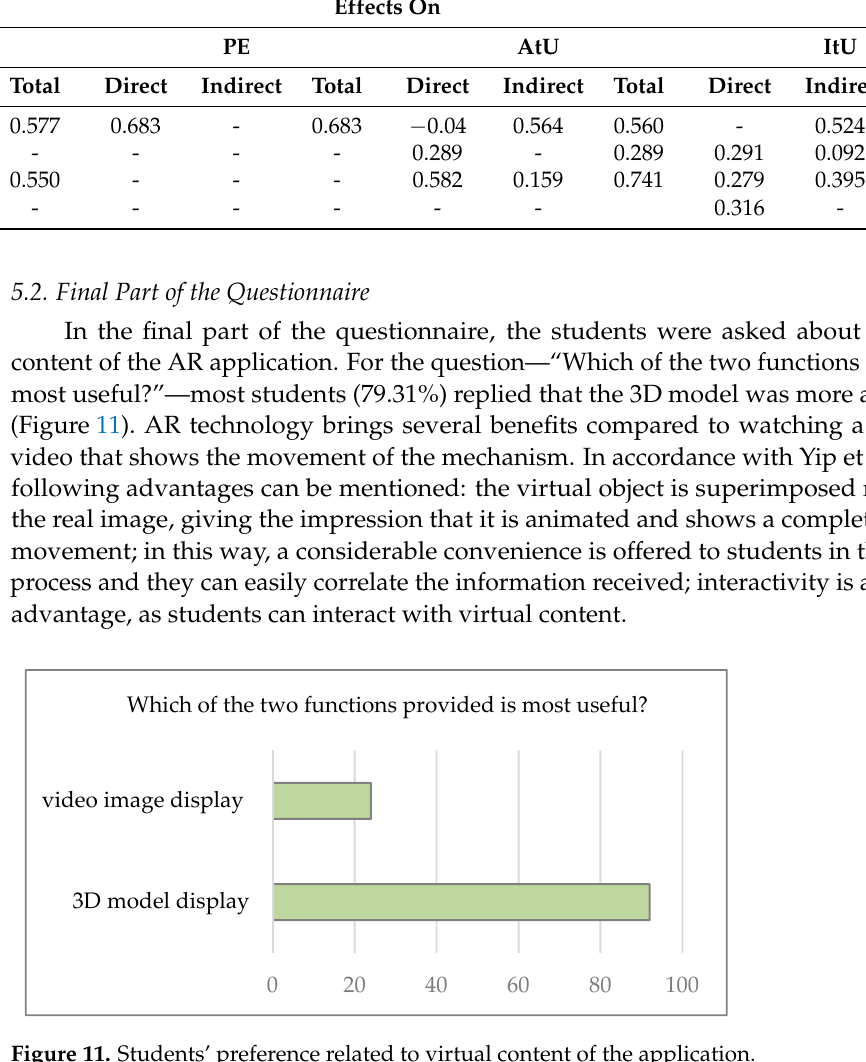
Table 9. Causal relationship: direct, indirect, and total effect of variables.